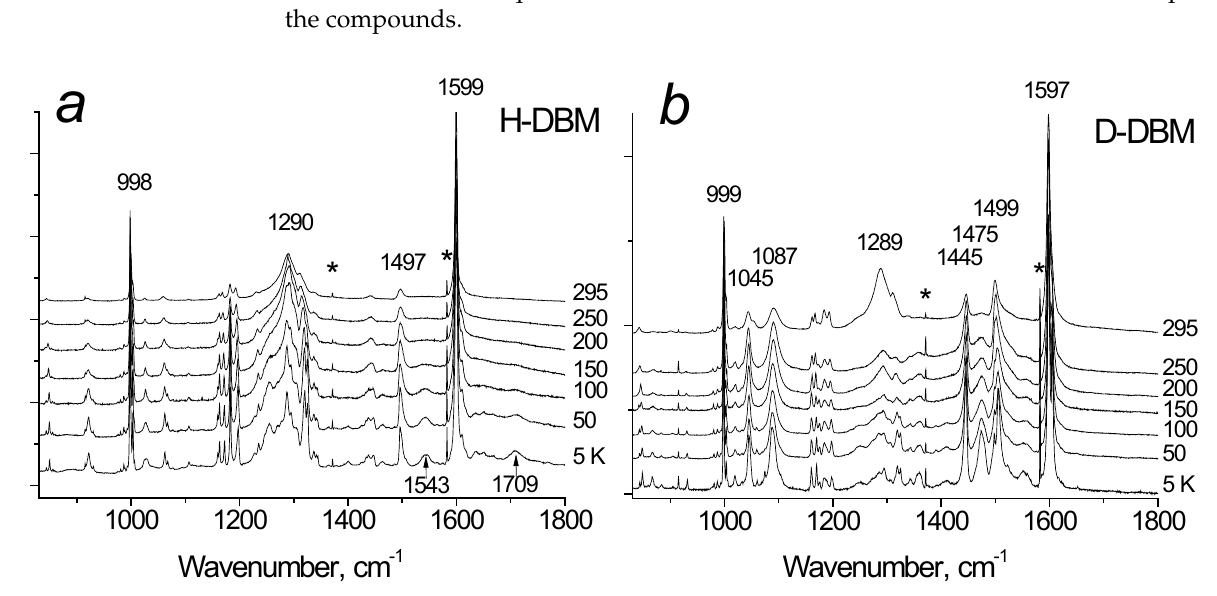
Figure 2. ( a , b ) The spectra of H − DBM ( a ) and D − DBM ( b ) at different temperatures in the range of the hydrogen bond vibrations. The asterisk (*) marks the positions of the line of the Ne lamp, which was registered at each temperature for the wavenumber correction of the spectra. Table 1. Calculated with M06-2X/6-311+G(d,p), the frequency of vibrations in 3-hydroxy-1,3- diphenylprop-2-en-1-one, including the displacement of the proton of the enol ring. H-DBM D-DBM Exper. Calc. Exper.